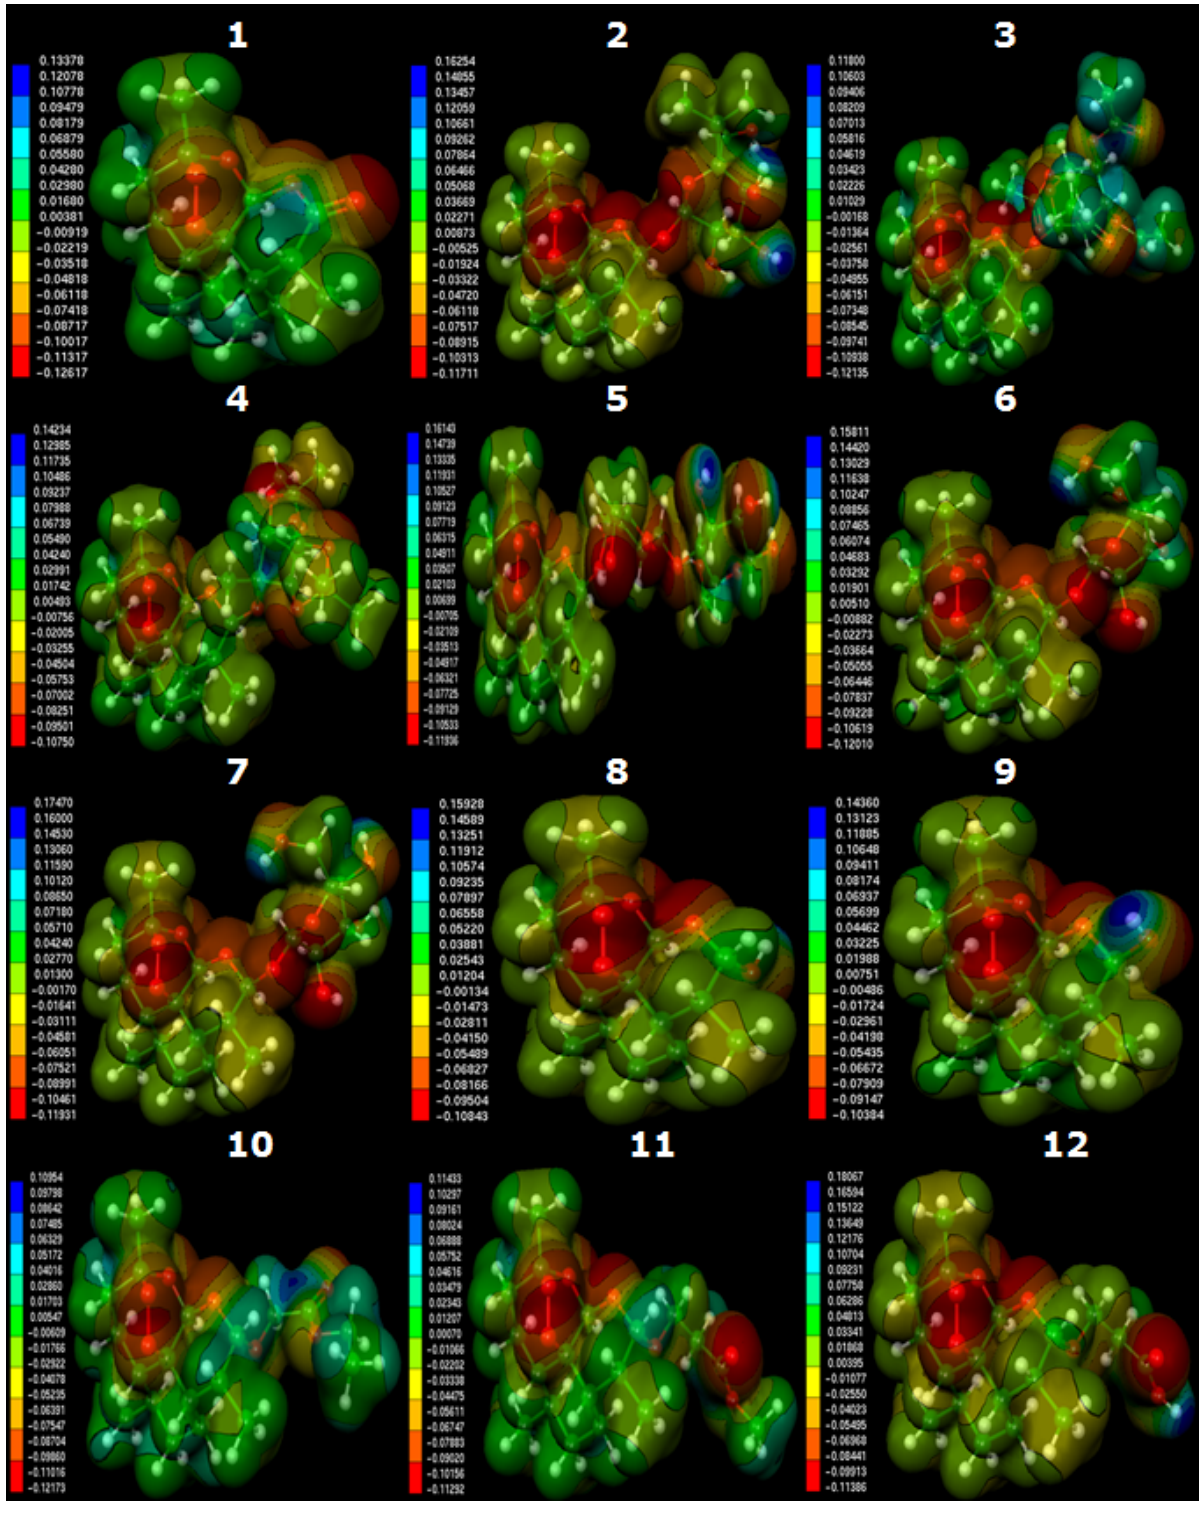
Figure 3. Molecular electrostatic potential maps of the studied artemisinin derivatives with antimalarial activity against Plasmodium falciparum (W-2